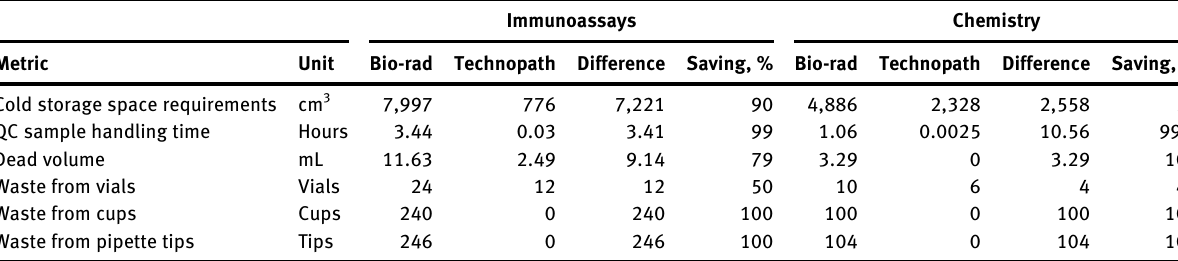
Table  : Summary of savings in an ef fi ciency study on different QC